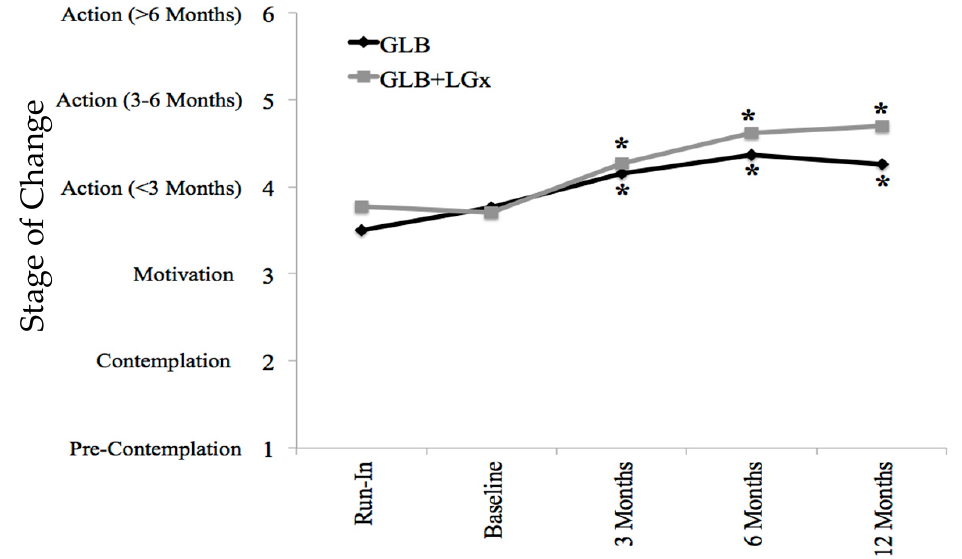
Figure 3. Stages of change by time point and group. Stage of change was measured on a Likert scale of 1 through 6 based on the transtheoretical model (stages of change); 1 represented pre-contemplation, 2 represented contemplation, 3 represented motivation, 4 represented action ( < 3 months), 5 represented action (for 3–6 months) and 6 represented maintenance ( > 6 months). Asterisks indicate significant di ff erences from run-in (pre-intervention), within groups: p ≤ 0.001 at all time points in both groups. GLB ( n = 70 with mean value imputation): Run-In 3.50 ± 0.18 (mean ± SE), 95% CI: 3.10–3.82; Baseline 3.76 ± 0.18, 95%CI: 3.41–4.12; 3 Months* 4.15 ± 0.15, 95% CI: 3.85–4.44; 6